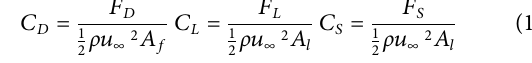
Frontiers in Future Transportation |